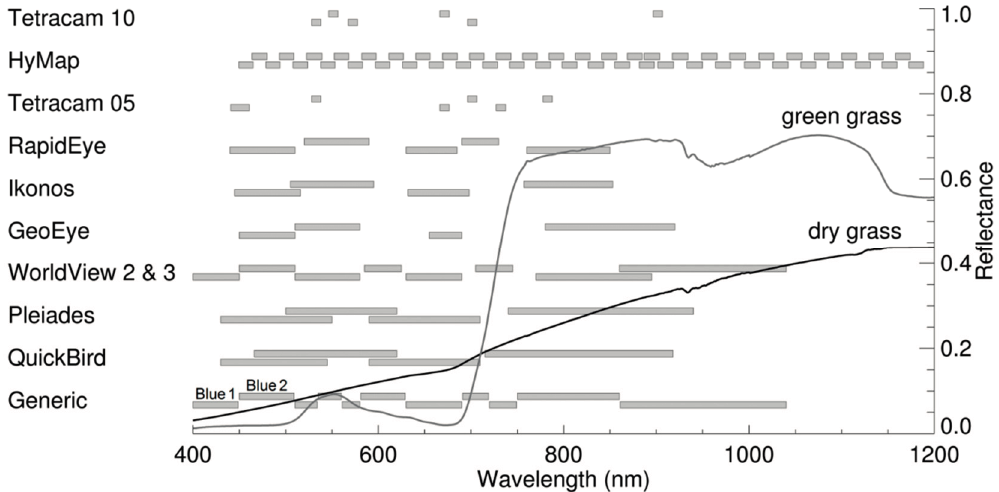
Figure 2. Band positions and widths for the sensors used in this